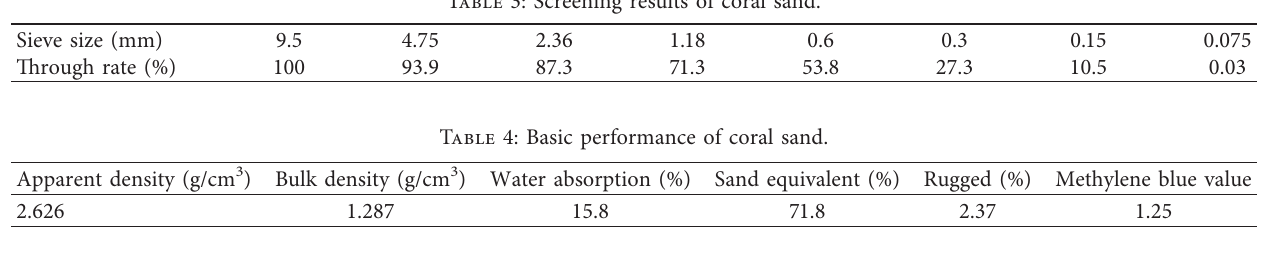
Table 5: The optimum water content and the maximum dry density.